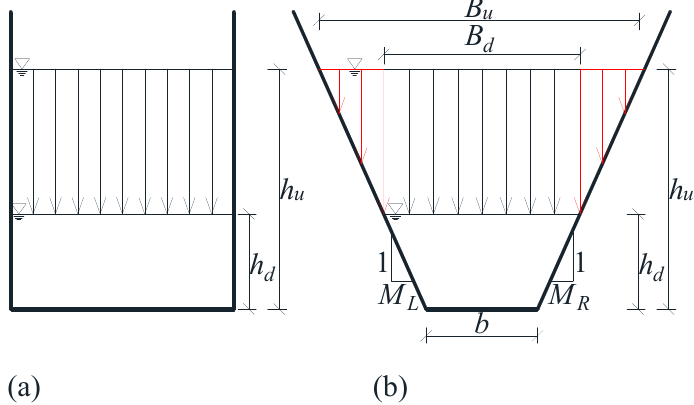
Figure 1. Pathways of water particles released from the upstream to downstream water surfaces with a wet-bed in: ( a ) A rectangular channel; ( b ) a trapezoidal channel.